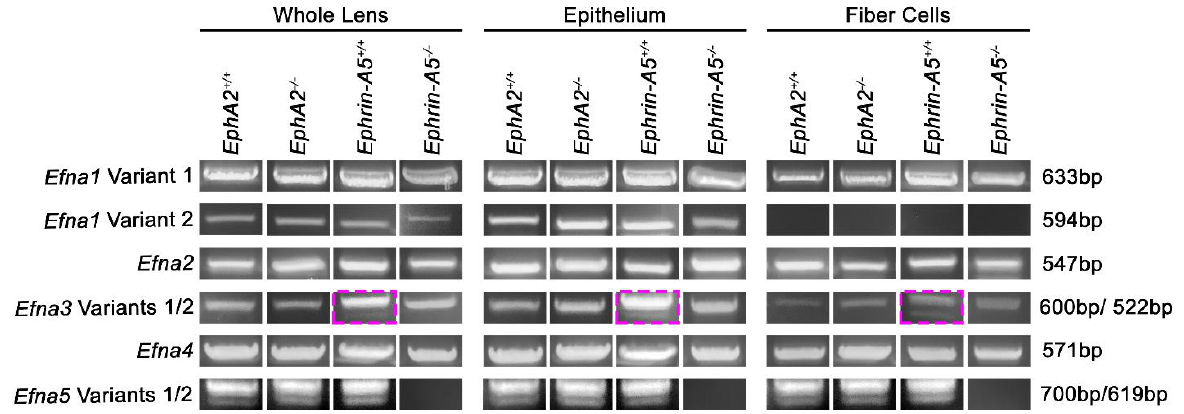
Figure 3. Efna transcripts, which encode for ephrin-A proteins, in whole lens, lens epithelial cell, or lens fiber cell RNA samples from 6-week-old EphA2 +/+ , EphA2 − / − , ephrin-A5 +/+ , and ephrin-A5 − / − mice. We detected Efna1 variant 1, Efna2 , Efna3 variant 1, Efna4 , and Efna5 variants 1 and 2 in the lens. Efna1 variant 2 was detected in the whole lens and epithelial cells, but not detected in fiber cells. Efna3 variant 2 was only detected in ephrin-A5 +/+ lens samples (magenta boxes).